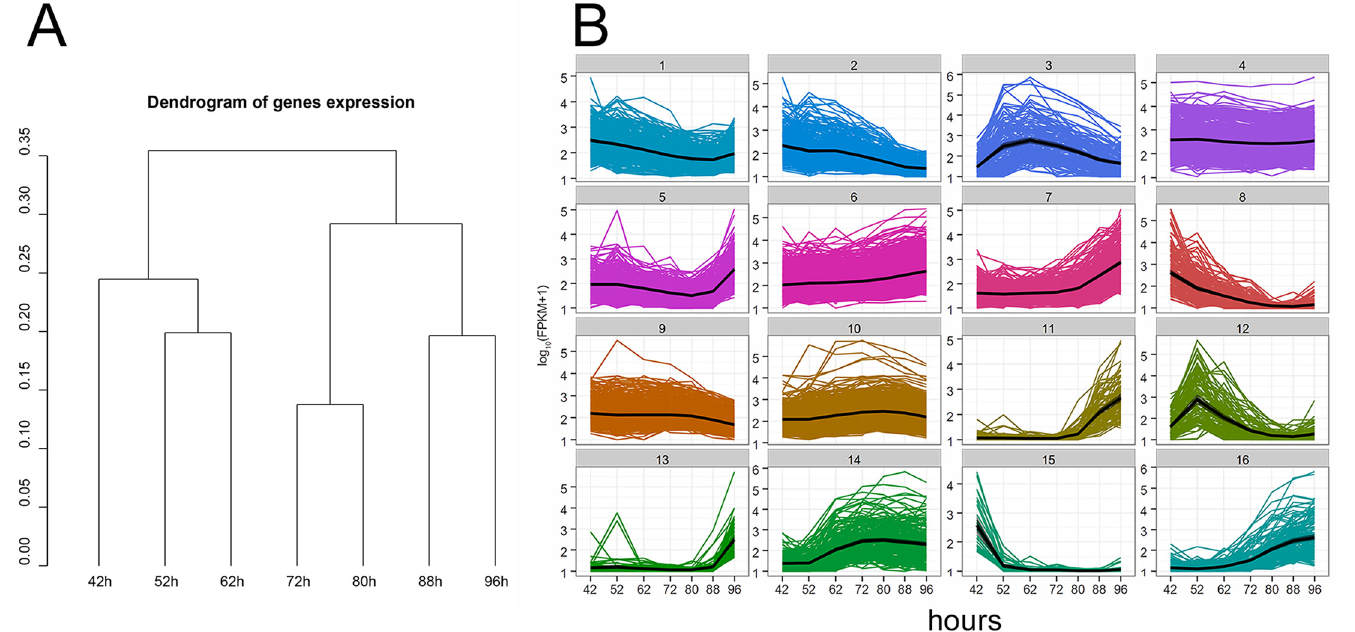
Fig 3. Gene expression clusters during the deposition of wing cuticle. A. The dendrogram shows the relationships between the gene expression patterns at different time points. The scale refers directly to the mutual Jensen-Shannon distance between branches. B. The gene expression patterns for all of the 16 clusters. The numbers on the Y axis show the log 10 (FPKM+1) values and the X axis shows the time. The graphs show the expression patterns for the members of each of the 16 clusters. Clustering methods are described in more detail in S1 File (Supplementary Methods). Colored lines represent the pattern for each gene and the black line represents the